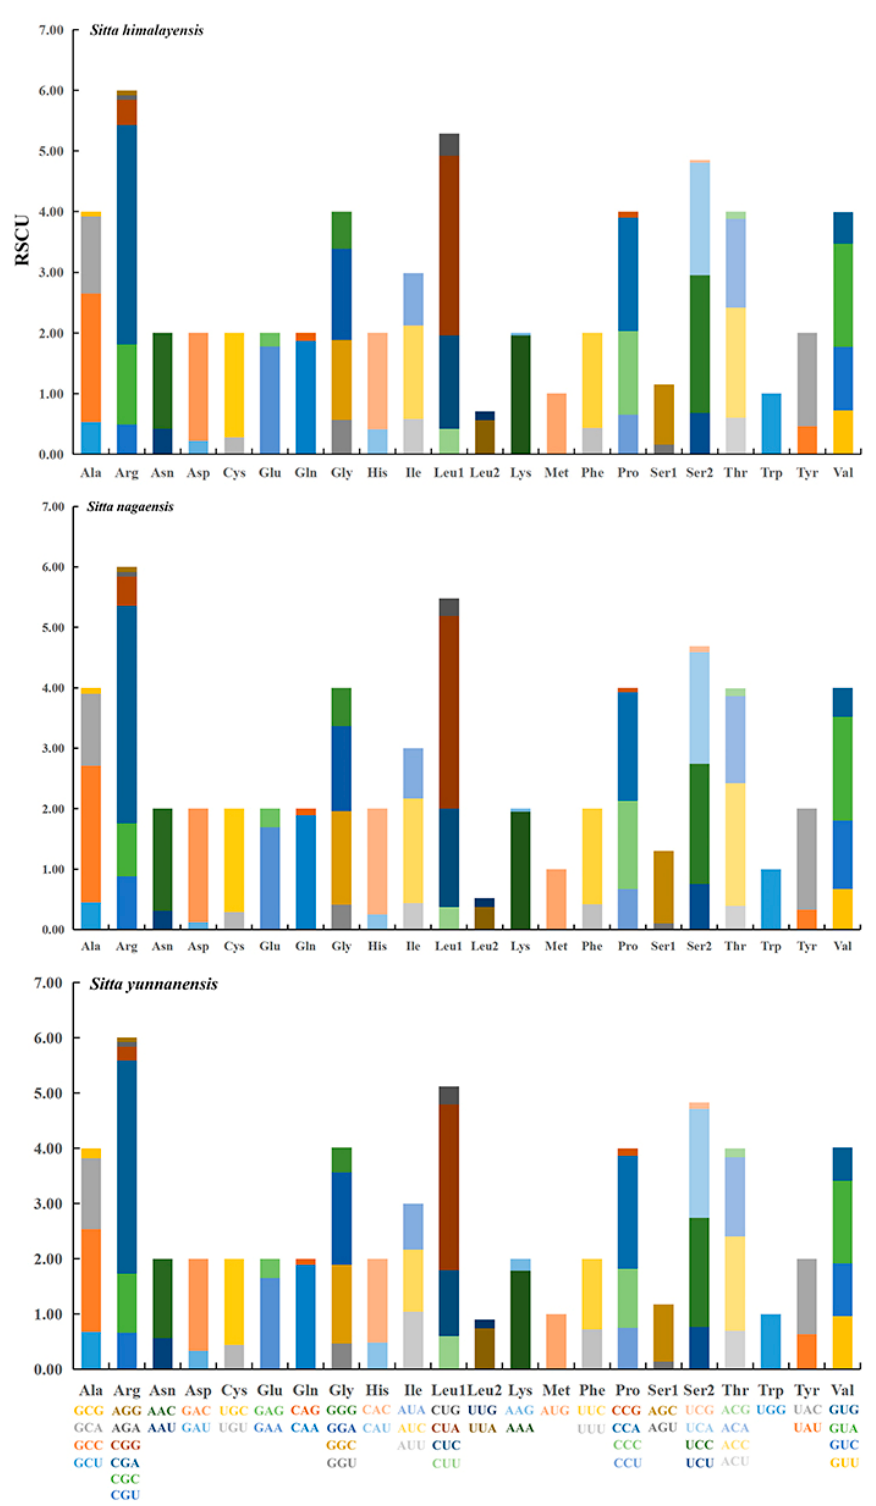
Figure 3. Relative synonymous codon usage (RSCU) for protein-coding genes of the three Sitta mitochondrial genomes. Codon families are provided on the x-axis.